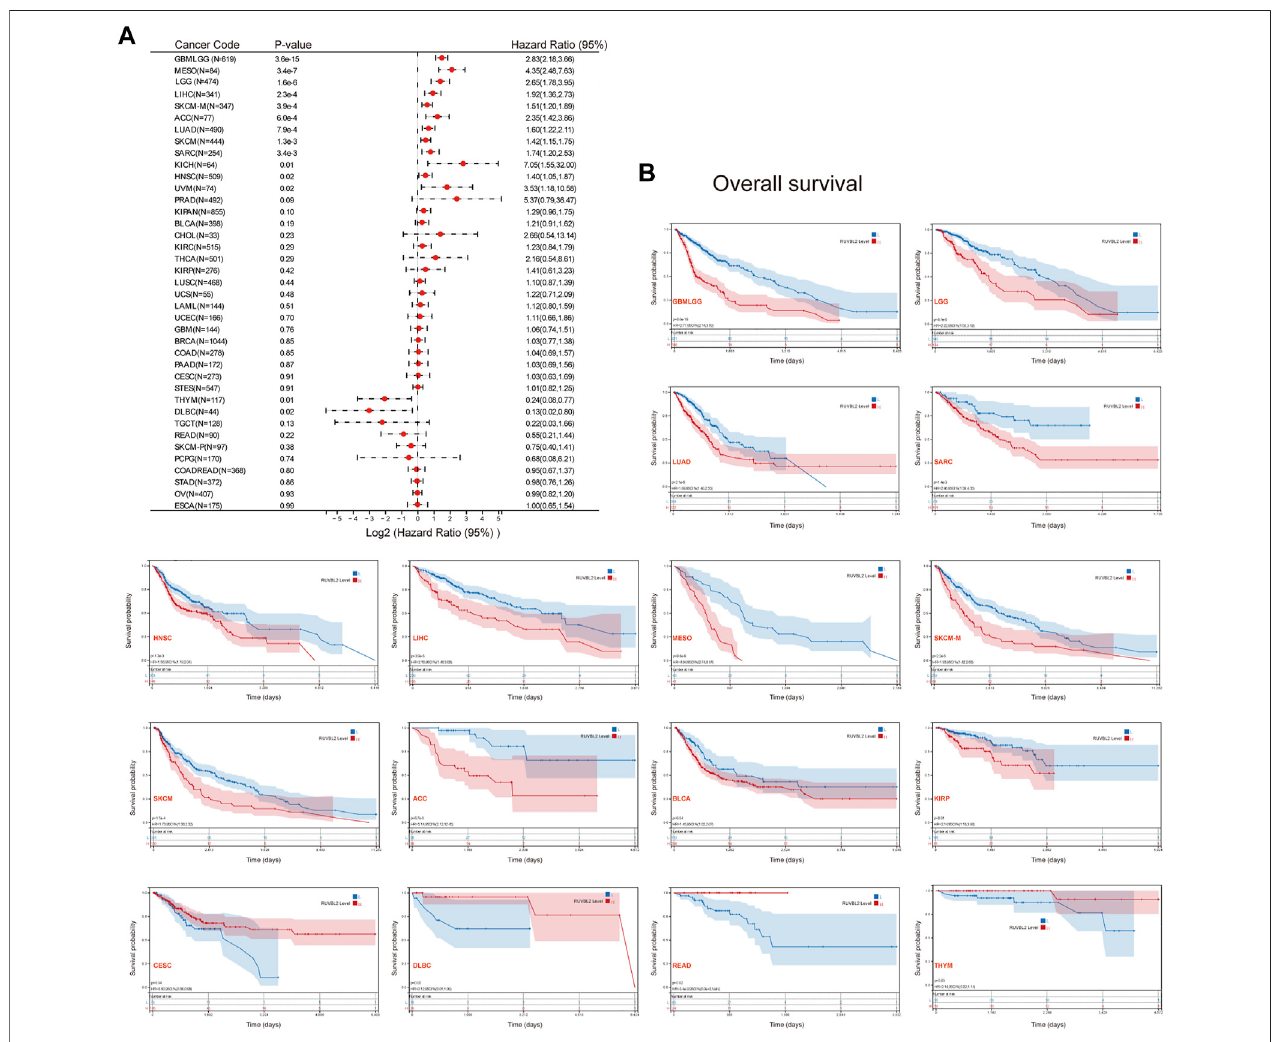
FIGURE2| Prognosis analysisofReptininpan-cancer. (A) ForestplotoftheassociationsbetweenReptinandOSin39types oftumors. (B) Kaplan-Meier survival analysis of the relationship between Reptin and OS. Only positive results were presented.